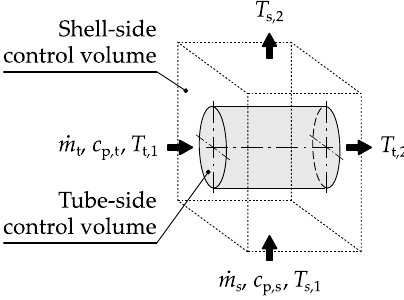
Figure 5. A pair of adjacent control volumes representing a portion of the tube side and the enclosing portion of the shell side.